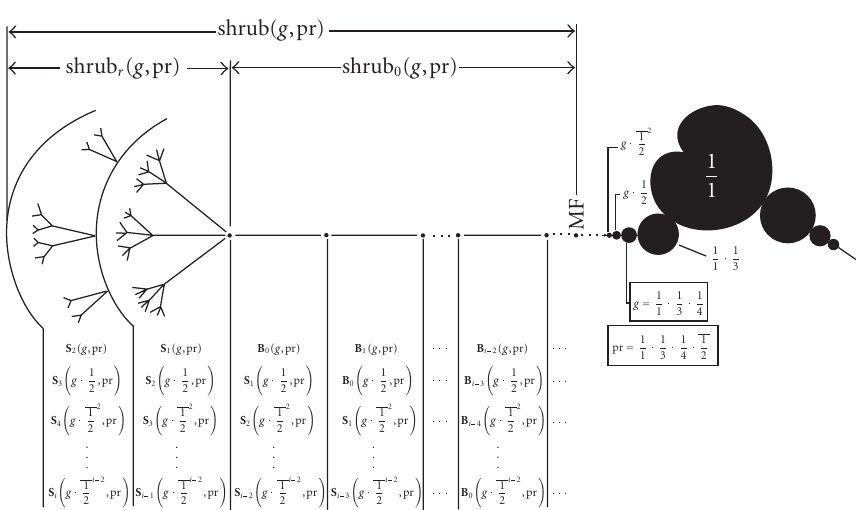
Figure 5.1. Sketch of the secondary route through the secondary hyperbolic component 1 / 1 · 1 / 3 · 1 / 4, showing the periodic route and the shrub with shrub 0 (1 / 1 · 1 / 3 · 1 / 4,1 / 1 · 1 / 3 · 1 / 4 · 1 / 2) and shrub r (1 / 1 · 1 / 3 · 1 / 4,1 / 1 · 1 / 3 · 1 / 4 · 1 / 2). The lower part shows a table with di ff erent names of each chaotic